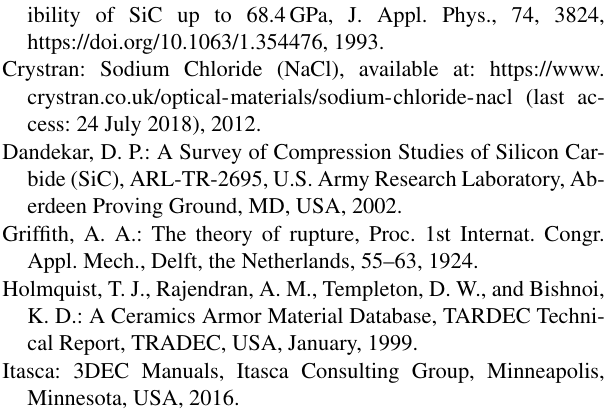
Figure 18. (a) Maximum principle stress [Pa]. (b) Maximum com- pression stress [Pa].